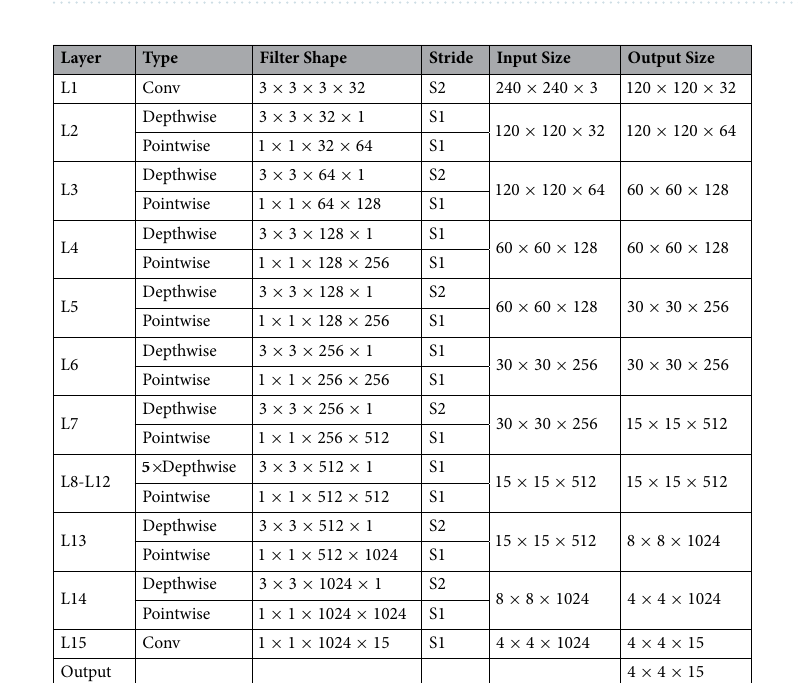
Figure 3. Architecture of our DNN for detection of colorectal polyps.